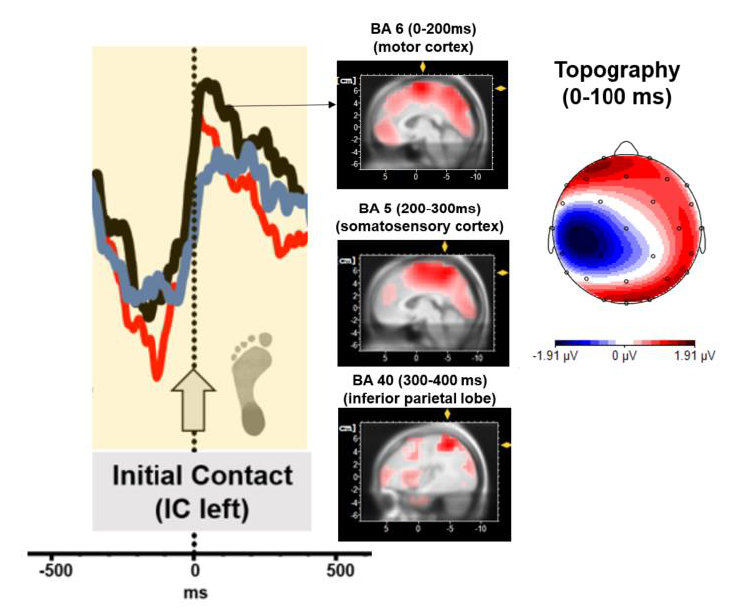
Figure 6. Gait-event-related potential (gERP) elicited by the left initial contact (IC), plotted as grand average (including data of all three volunteers) with BrainVison Analyzer software at the left hemisphere electrode CP1 for the di ff erent walking conditions of spontaneous (black) and instructed (small steps (red), large steps (blue)) treadmill walking. Yellow shaded part, please see explanation in the text. Topography of the gERP elicited by the left initial contact in the time window from 0-100 ms after the IC onset (right column). Source imaging plots (averaged across the di ff erent walking conditions) from BrainVison Analyzer software for the time course of the gERP from 0–200 ms, 200–300 ms, and from 300–400 ms after left IC